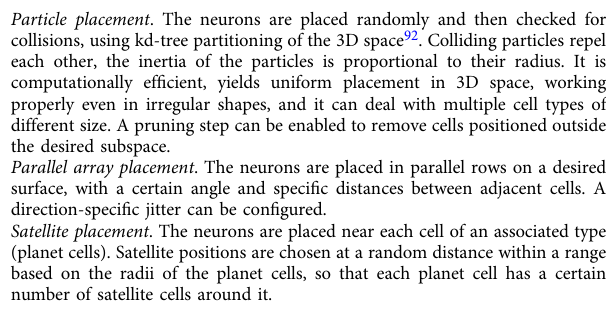
Fig. 9 Activation of a vertical neuronal column in the cerebellar cortex. A whisker air-puff stimulus (the mf burst) is delivered to 4 adjacent mf s, which branch in 4 glom clusters. GrC s respond rapidly with a burst when at least 2 dendrites are activated. A GrC dense cluster is formed and the signal propagates up through an aa bundle and transversally along a pf beam. GoC s receive the signal both on basolateral and apical dendrites. PC s vertically on top of the active cluster are invested by aa and pf synaptic inputs. On-beam SC s and BC s receive signals through pf synapses; SC axons inhibit mainly on- beam PC s, while BC axons inhibit mainly off-beam PC s. The membrane potential traces ( mf burst starts at 500 ms) are shown for each neuronal population. Traces in the three columns correspond to three different release probabilities at the mf - GrC synapses: u = 0.1, u = 0.43 (control condition used in the rest of the paper), u = 0.9. The lower and higher u-values are typical of long-term synaptic depression and potentiation in the models, synapse models and devices de fi ne the simulator-speci fi c representation of neuron and connection types and input/output variables (Fig. 1). The BSB is the only